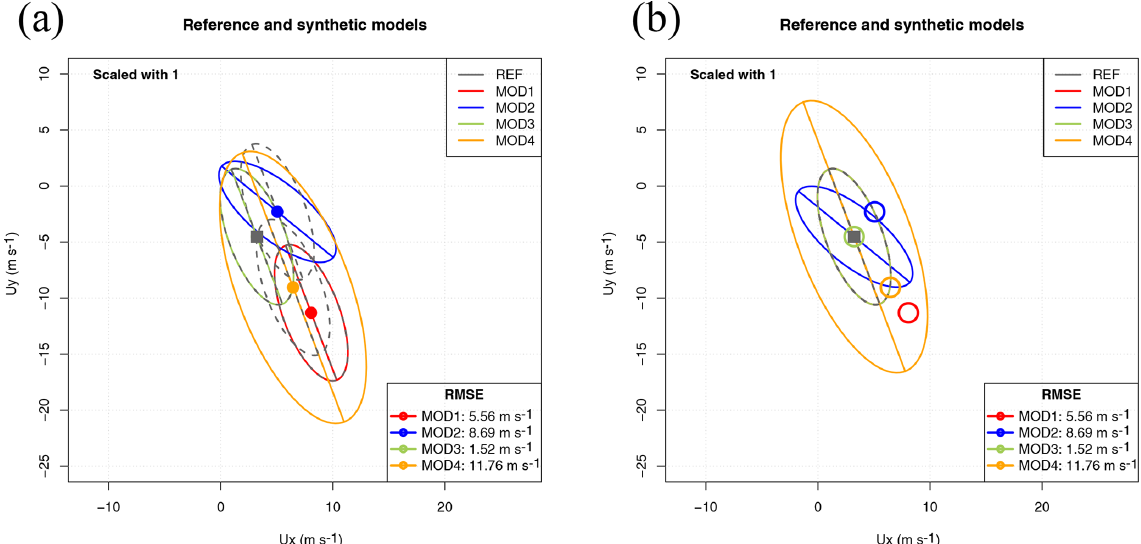
Figure 4. Uncentred (a) and centred (b) versions of the Sailor diagram after placing the ellipses from all the synthetic datasets on the same